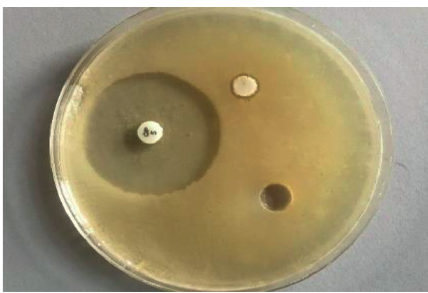
Figure 4: Antibacterial activity of Camellia sinensis AgNP against Staphylococcus